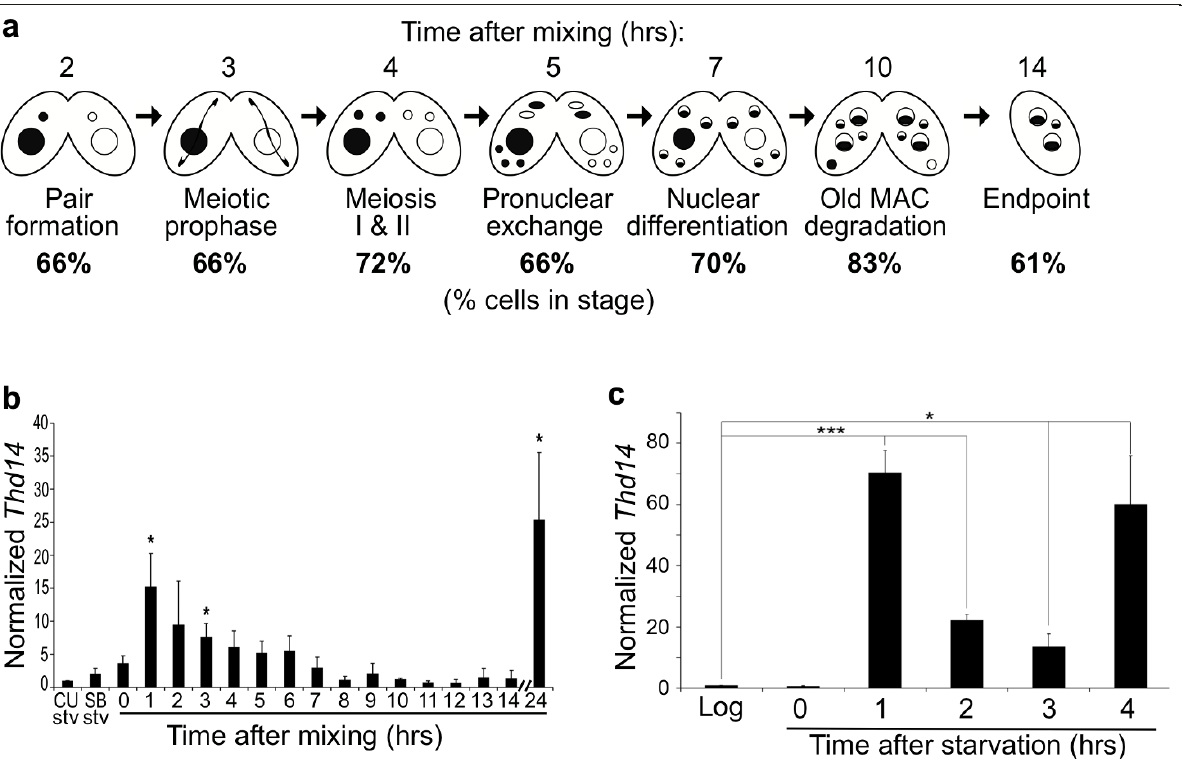
Figure 5 Thd14 expression peaks in pre-meiotic stages . a Synchrony of conjugating cells used for cDNA analyses. Cells of two different mating types were mixed to initiate conjugation, and samples of the conjugating culture were dried and stained with DAPI for visualization of stages by fluorescence microscopy every hour. Hours post mixing are indicated ("hrs ” ) above the corresponding stages illustrated. The percentage of conjugating pairs in each stage at the corresponding time is indicated below the diagram. The last stage is percentage of single cells. b Relative THD14 expression of starved CU428 (CU Stv) and SB1969 (SB Stv) as well as during conjugation (0-14 and 24 hours after mixing) was determined using quantitative real-time PCR. THD14 expression was normalized to CYP1 expression ( THD14/CYP1 ) and the levels of THD14 expression were set relative to the starved CU428 (normalized values of each sample/CU428). Error bars represent the standard deviation of three separate trials and asterisks indicate time points that had a significant (p < 0.05) increase in expression of THD14 compared to either the starved CU428 cells (CU Stv) or immediately after mixing (0 hrs). THD14 mRNA levels increased early in conjugation at (1-3 hours) and late (24 hours) after completion of conjugation. c Relative THD14 expression of logarithmically growing CU428 ("Log ” ) as well as during starvation (hours 0 through 4) was determined using quantitative real-time PCR. THD14 expression was normalized to that of BTU1 and the levels of THD14 expression were set relative to logarithmically growing cells. Error bars represent the standard deviation of three separate trials and asterisks indicate time points that had a significant (* p < 0.05, *** p < 0.005) increase in expression of THD14 compared to logarithmically growing